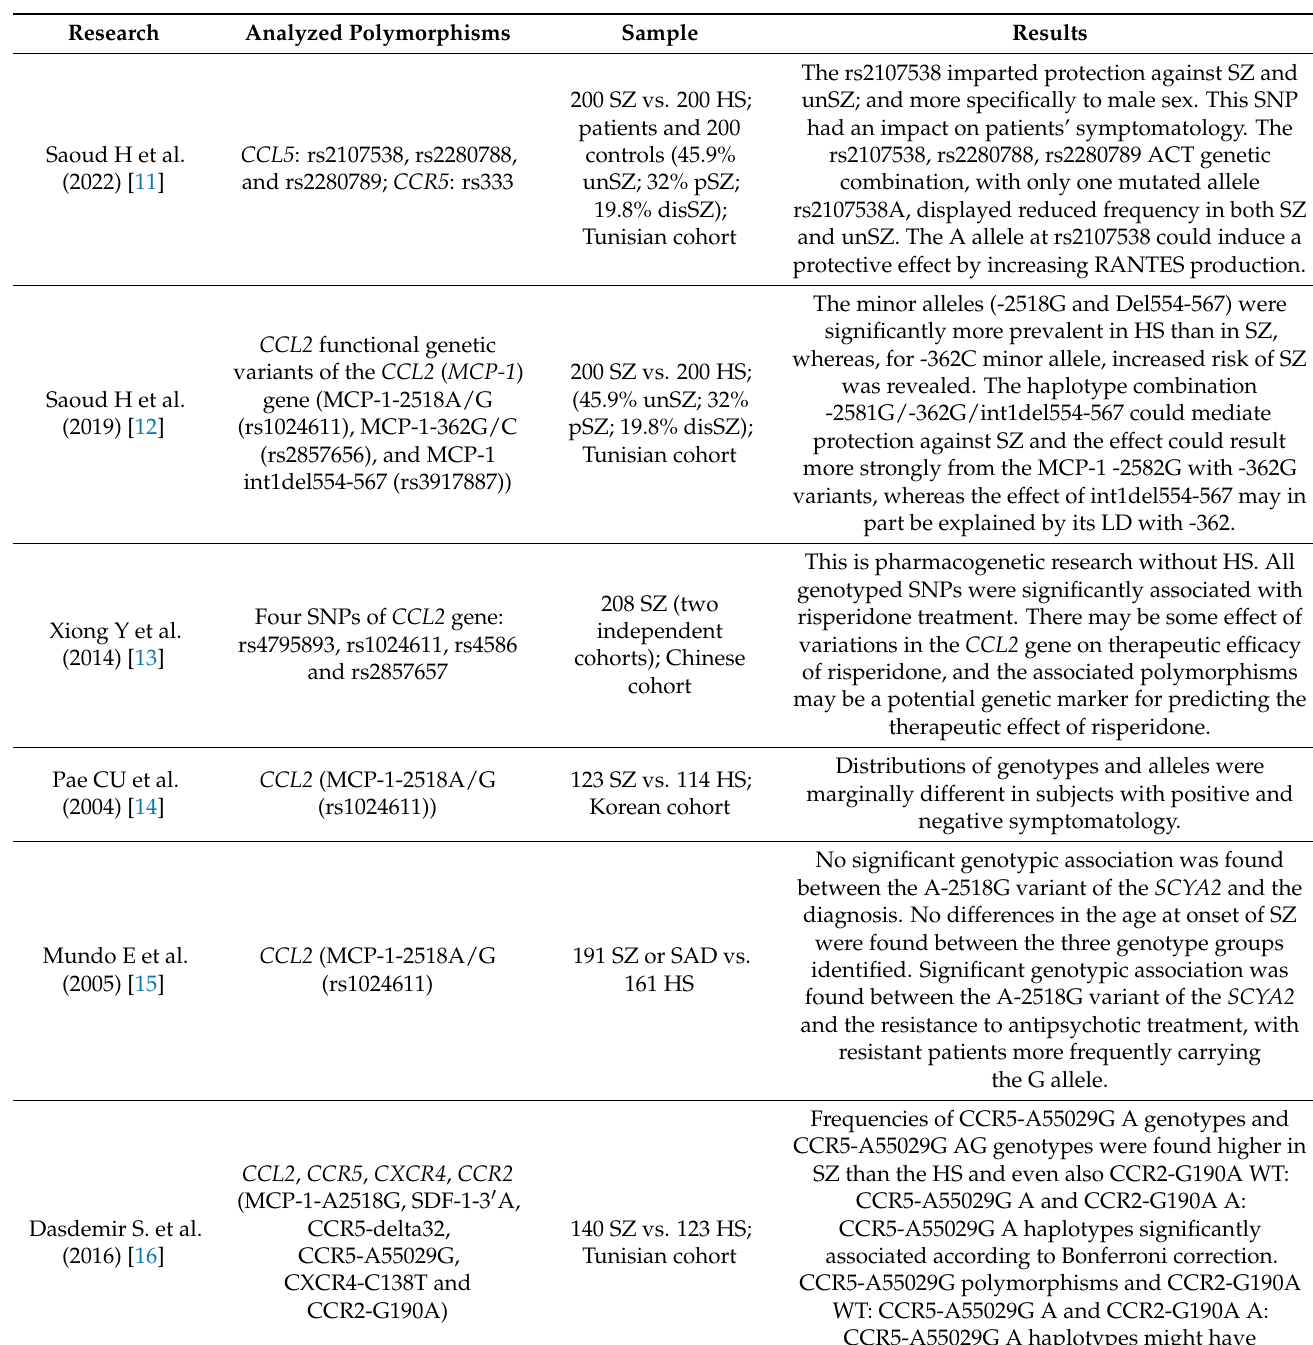
Table 1. Genetic association of chemokine and chemokine receptor gene polymorphisms with